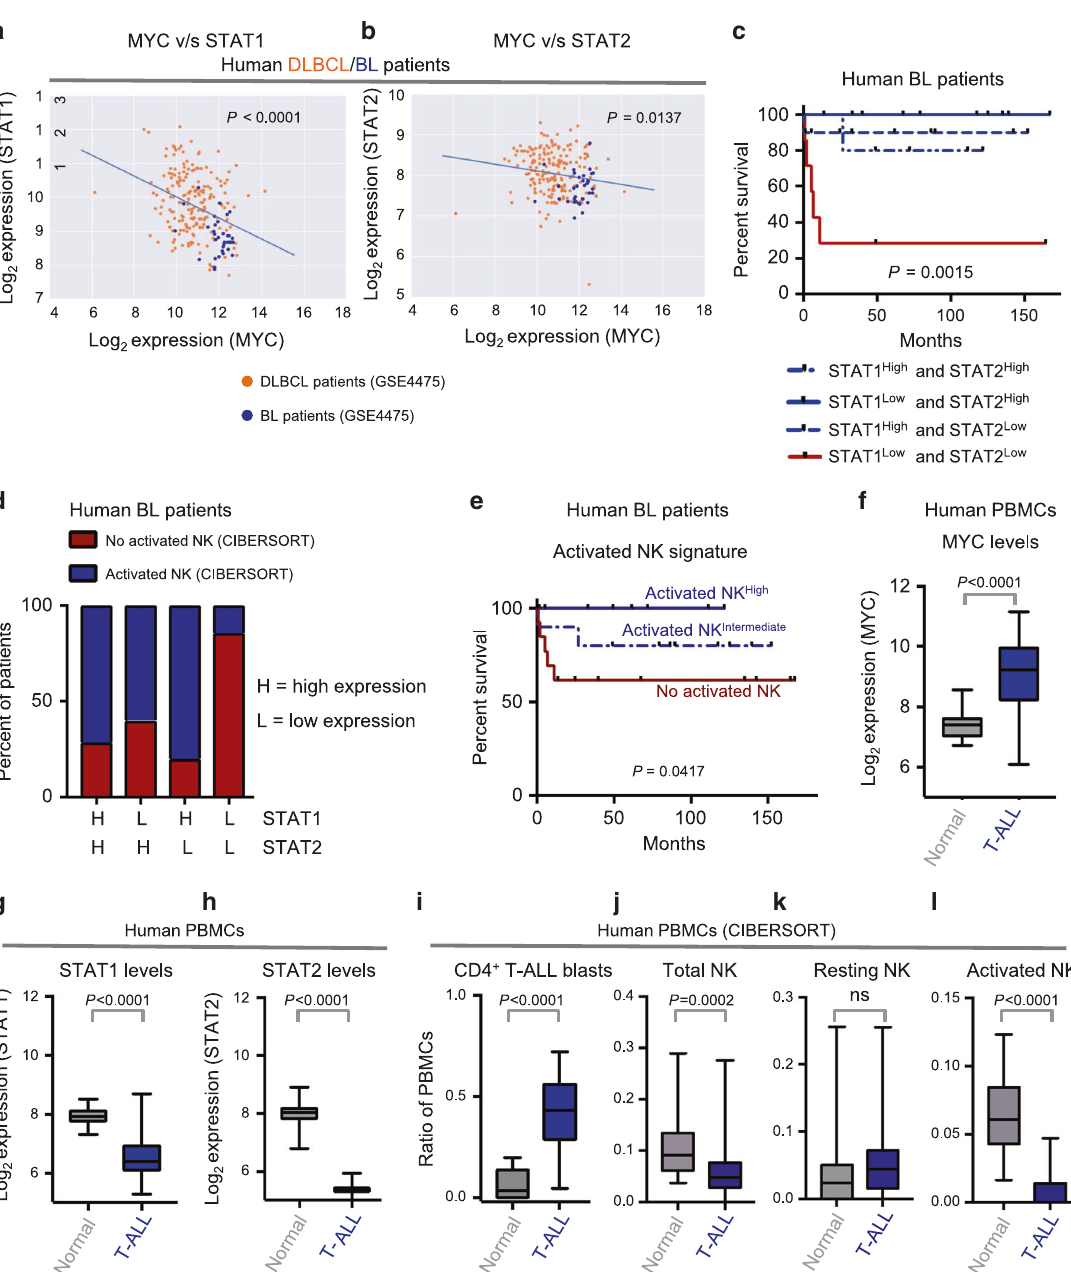
Fig. 6 MYC High human lymphomas exhibit reduced STAT1/2 and NK cell-mediated immune surveillance. a , b Correlations between mRNA levels of MYC and STAT1 ( a ), or MYC and STAT2 ( b ) in classical MYC-driven human lymphoma patient samples ( n = 187, DLBCL, orange; n = 34, BL, blue). c Multivariate analysis comparing overall survival probabilities of BL patients ( n = 34, GSE4475) when divided into four groups based on combined levels of STAT1 and STAT2. d Proportions of patients with no activated NK cells (estimated by CIBERSORT) when BL patients ( n = 34, GSE4475) are divided into four groups based on combined levels of STAT1 and STAT2. e Comparison of overall survival probabilities of BL patients ( n = 34, GSE4475) separated into three categories based on levels of activated NK cells in the tumor estimated by CIBERSORT, as none (0%, no activated NK), intermediate (activated NK Intermediate ) and high (activated NK High ). f – h Comparison of mRNA levels of MYC ( f ), STAT1 ( g ) and STAT2 ( h ) in mononuclear cells isolated from healthy human blood ( n = 20) and from blood of T-ALL patients ( n = 48, GSE62156). i – l CIBERSORT estimates of relative proportions of T cell blasts ( i ), and NK subsets, namely, total NK ( j ), resting NK ( k ) and activated NK ( l ), in peripheral blood mononuclear cells isolated from healthy individuals ( n = 20) and T-ALL patients ( n = 48, GSE62156). p -values for all survival analyses have been calculated using the log-rank test. p -values for all other analyses have been calculated using a two-sided Mann – Whitney test. p -values: ns not signi fi cant. For all box plots, the center is at the median, minima and maxima are indicated by whiskers, and the box represents data between the 25th and 75th